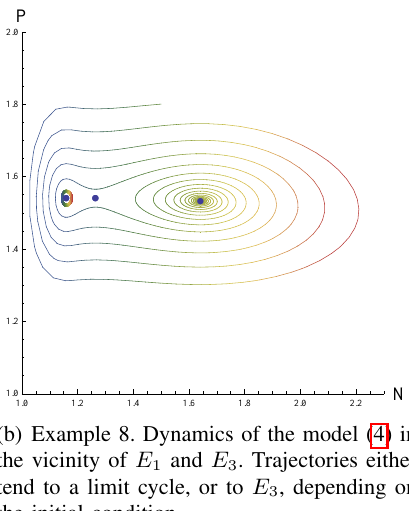
(a) Example 8. E 1 is unstable and E 3 is locally asymptotically stable; the thick dashed line separates the basin of attraction of E K .